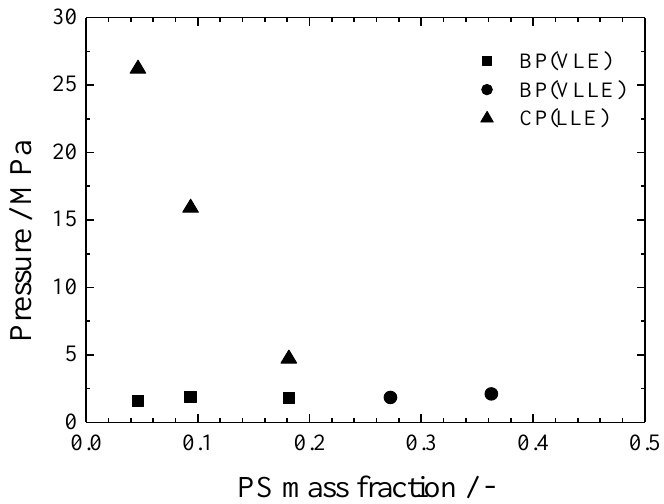
Figure 5. Effect of the MTMS:PS ratio on a CO 2 /MTMS/PS ternary system at 313.2 K and constant CO 2 mass fraction of 0.09.